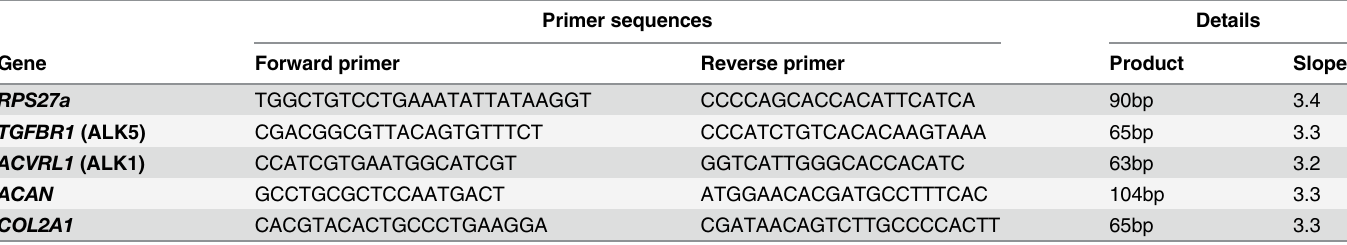
Table 1. List of primers used for